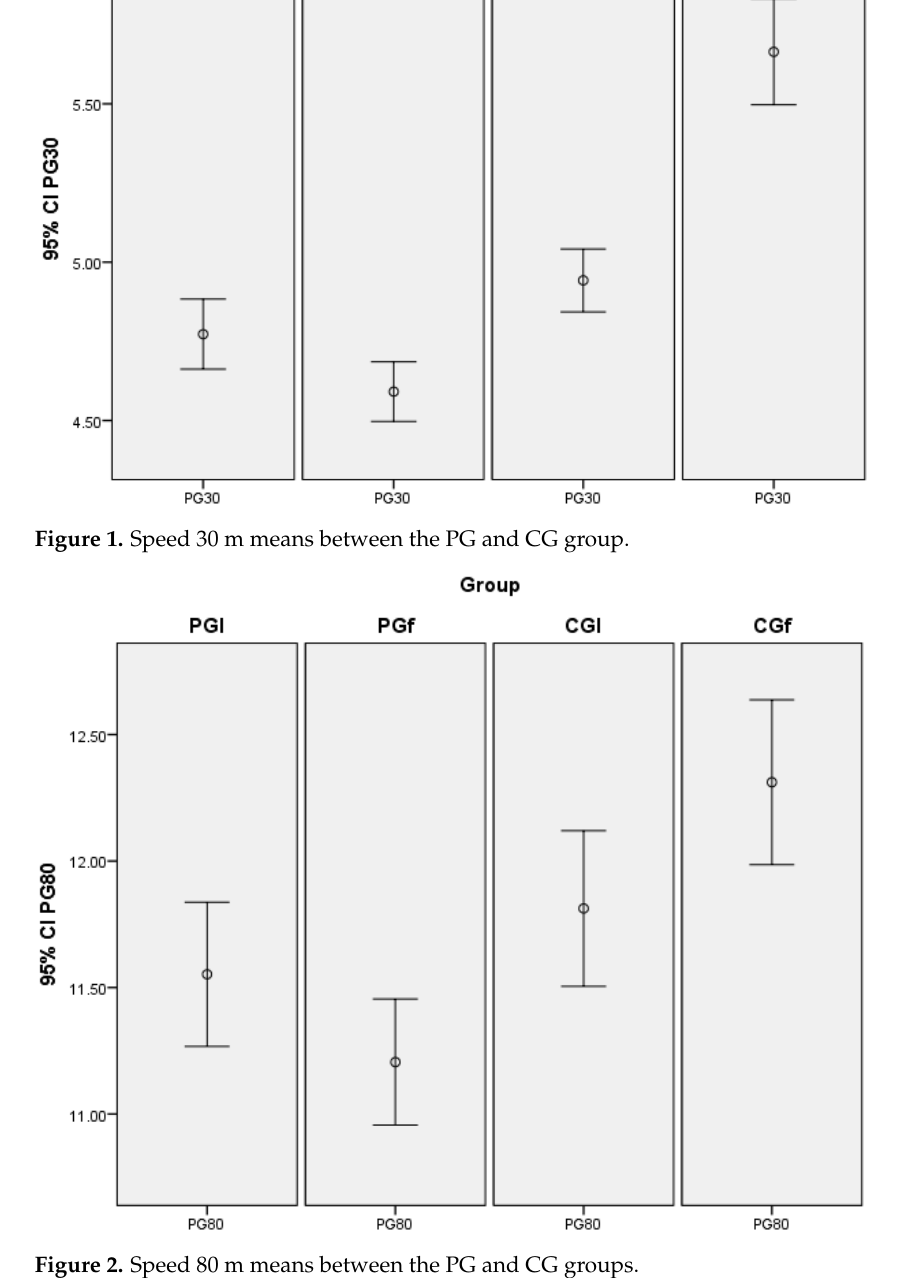
Figure 2. Speed 80 m means between the PG and CG groups.